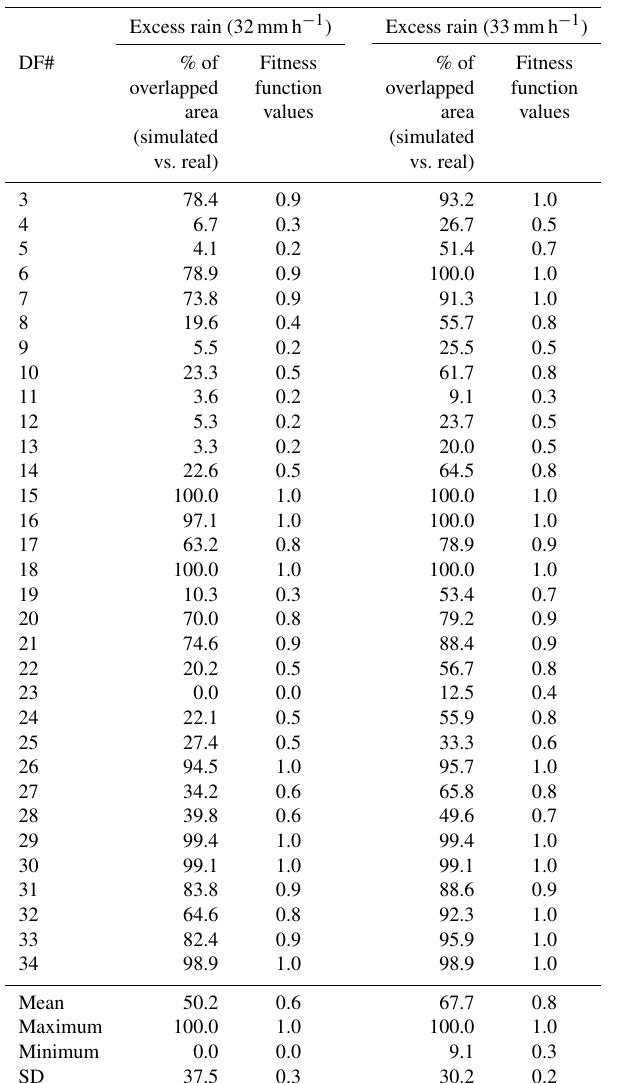
Table 5. Validation of 32 debris flows (not used for calibration) con- sidering the modeling results using 32 and 33mmh − 1 of excess rain.